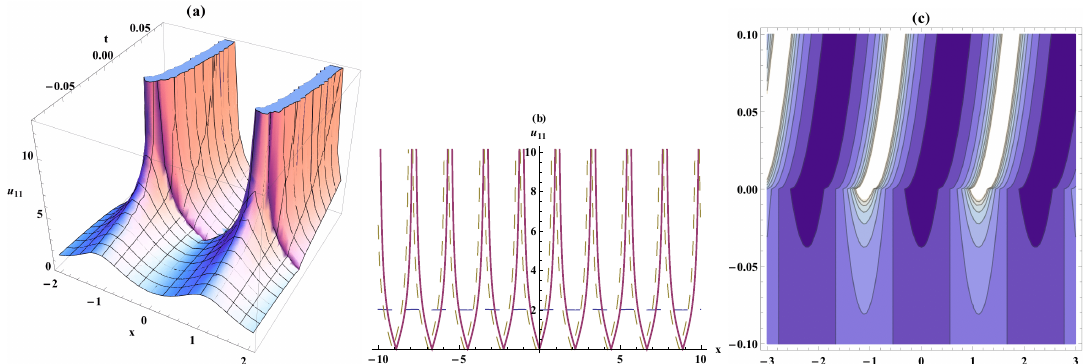
Figure 11. Solitary wave, the bistable wave amplitude and contour plots for Equation (91). On the respectively interval { x , − 2.05,2.05 } , { t , − 0.08,0.08 } , { x , − 10,10 } , { t , − 1,1 } , { x , − 3,3 } , { t , − 0.1,0.1 } .